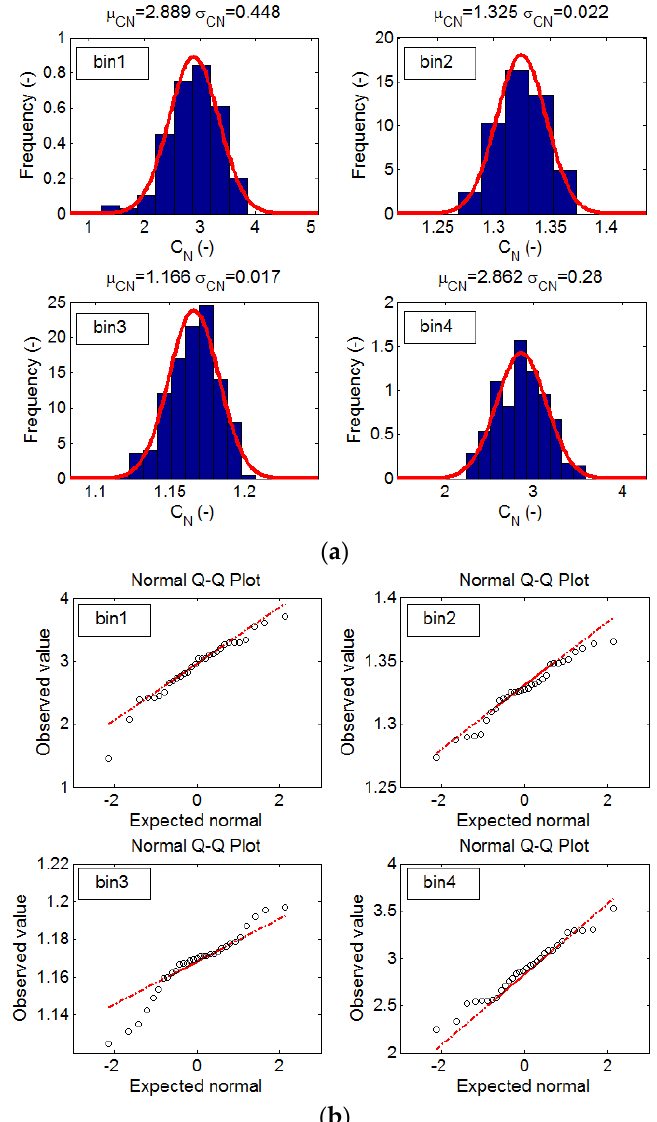
Figure 13. ( a ) Histogram, and ( b ) normal Quantile–Quantile of the normal force coefficients at U ∞ = 15 m/s and Φ = 30° at r/R = 0.30.